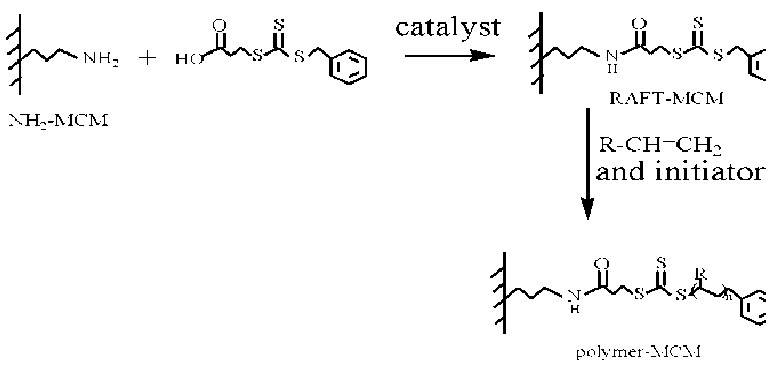
Figure 3. RAFT method for grafting polymer onto the mesoporous